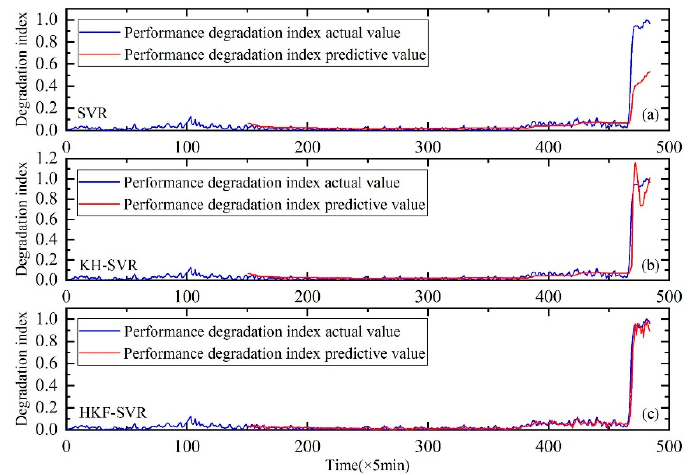
Figure 16. Performance degradation prediction of the rolling bearings, ( a ) is the result of SVR, ( b ) is